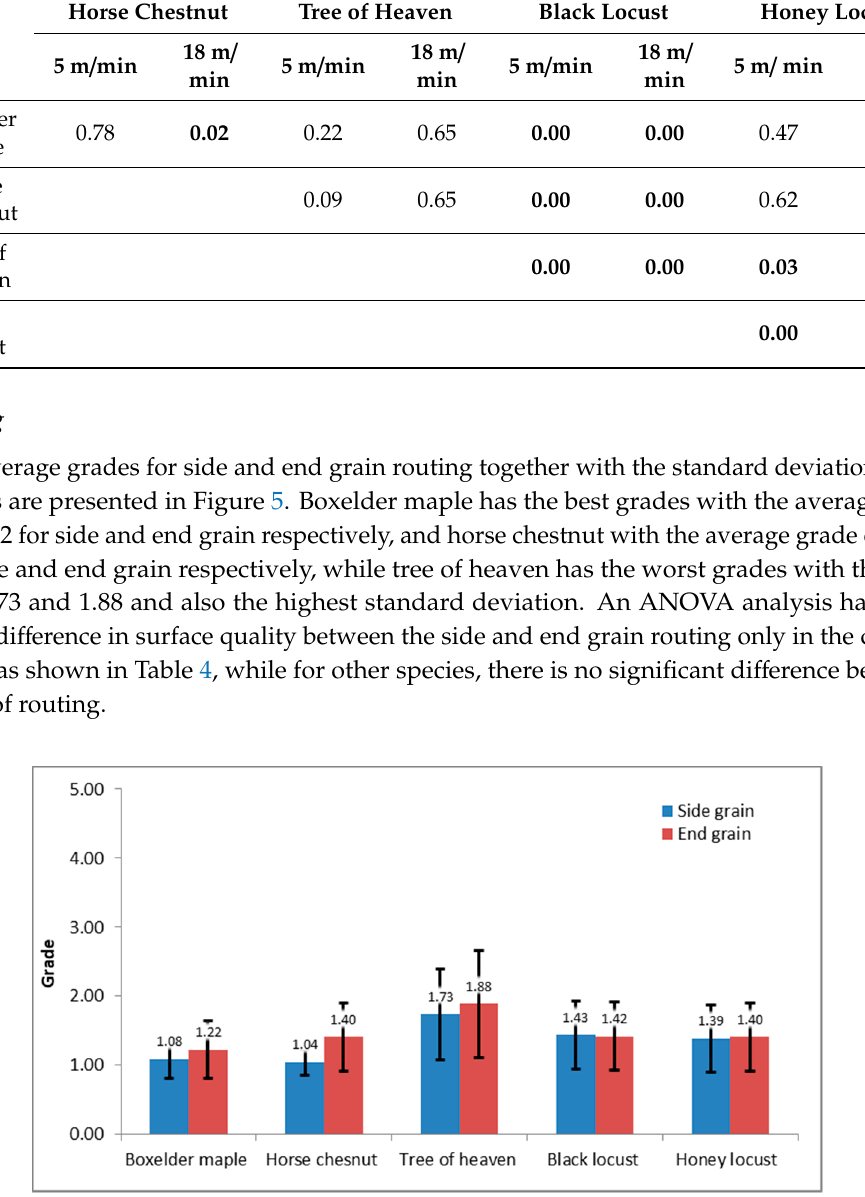
Figure 5. Average surface quality grades and standard deviations for tree species at side and end grain routing. Table 4. Statistical difference of the routing surface quality grades between side and end grain expressed by the p -value of the ANOVA analysis. The values in bold indicate a significant difference.